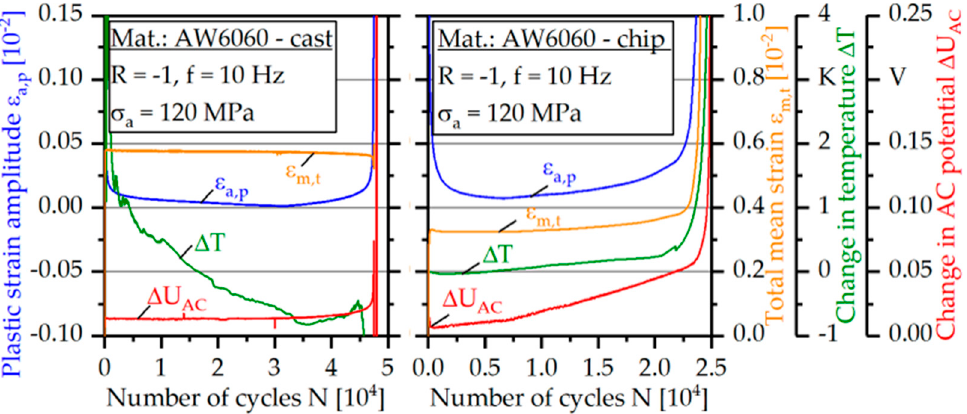
Figure 8. Constant amplitude tests of cast-based and chip-based specimens ( σ a = 120 MPa).